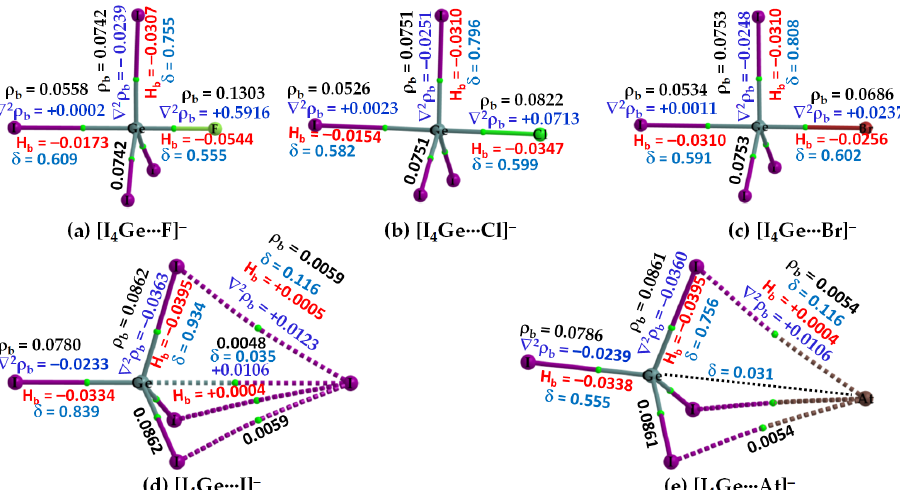
Figure 5. ( a – e ) [ωB97X -D/def2-QZVPPD] level QTIM-based molecular graphs of [I 4 Si ··· X − ] (X = F, Cl, Br, I, At), showing the bond paths (solid and dotted lines in atom color) and bond critical points (tiny spheres in green) between bonded atomic basins. Large spheres represent the atomic basins, with atoms labeled. The dotted black line in ( d , e ) is artificially drawn to represent the presence of tetrel bond between Si and X (X = I, At). The charge density (  b ), the Laplacian of the charge density (  2  b ), the total energy density (H b ), and the delocalization index (δ) values are shown in black, blue, red, and faint-blue fonts (in a.u.), respectively.